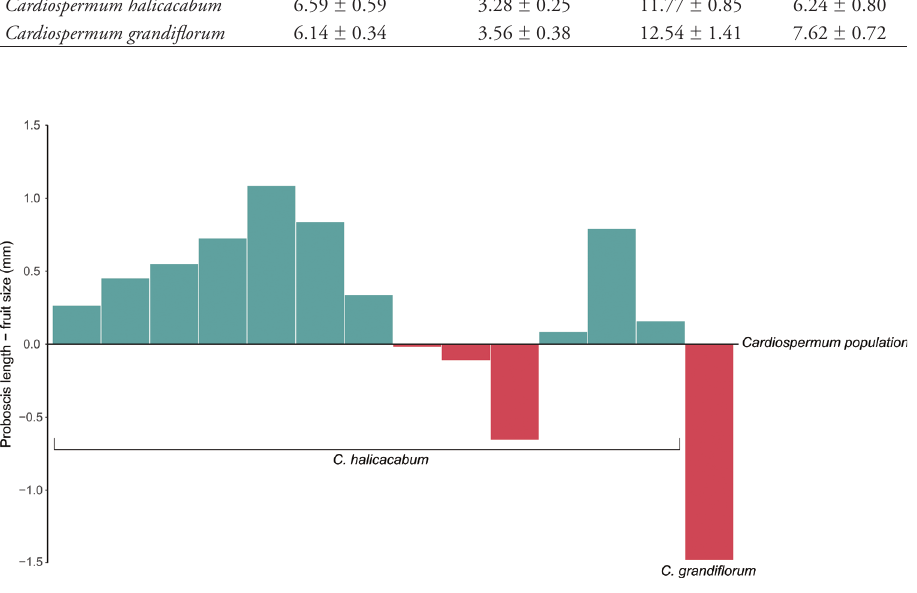
Figure 6. Difference between average proboscis length and average fruit size (i.e. proboscis length - fruit size) for Leptocoris mutilatus and Cardiospermum populations in KNP. Green bars represent populations in which soapberry bugs are well-suited to feed on their Cardiospermum hosts (i.e. proboscis length > fruit size) and red bars represent populations in which soapberry bugs are poorly matched (i.e. proboscis length < fruit